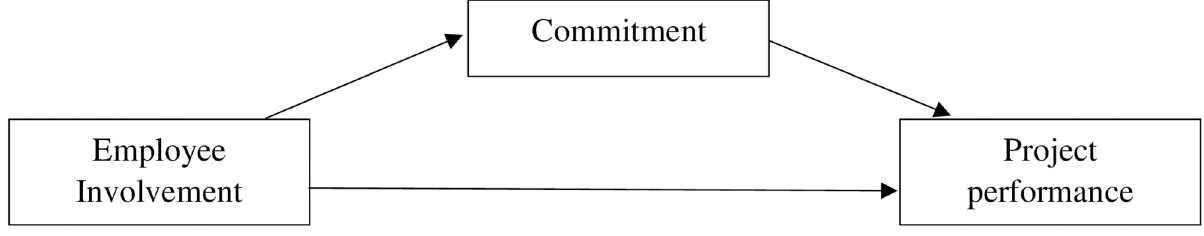
Fig 2. Mediation